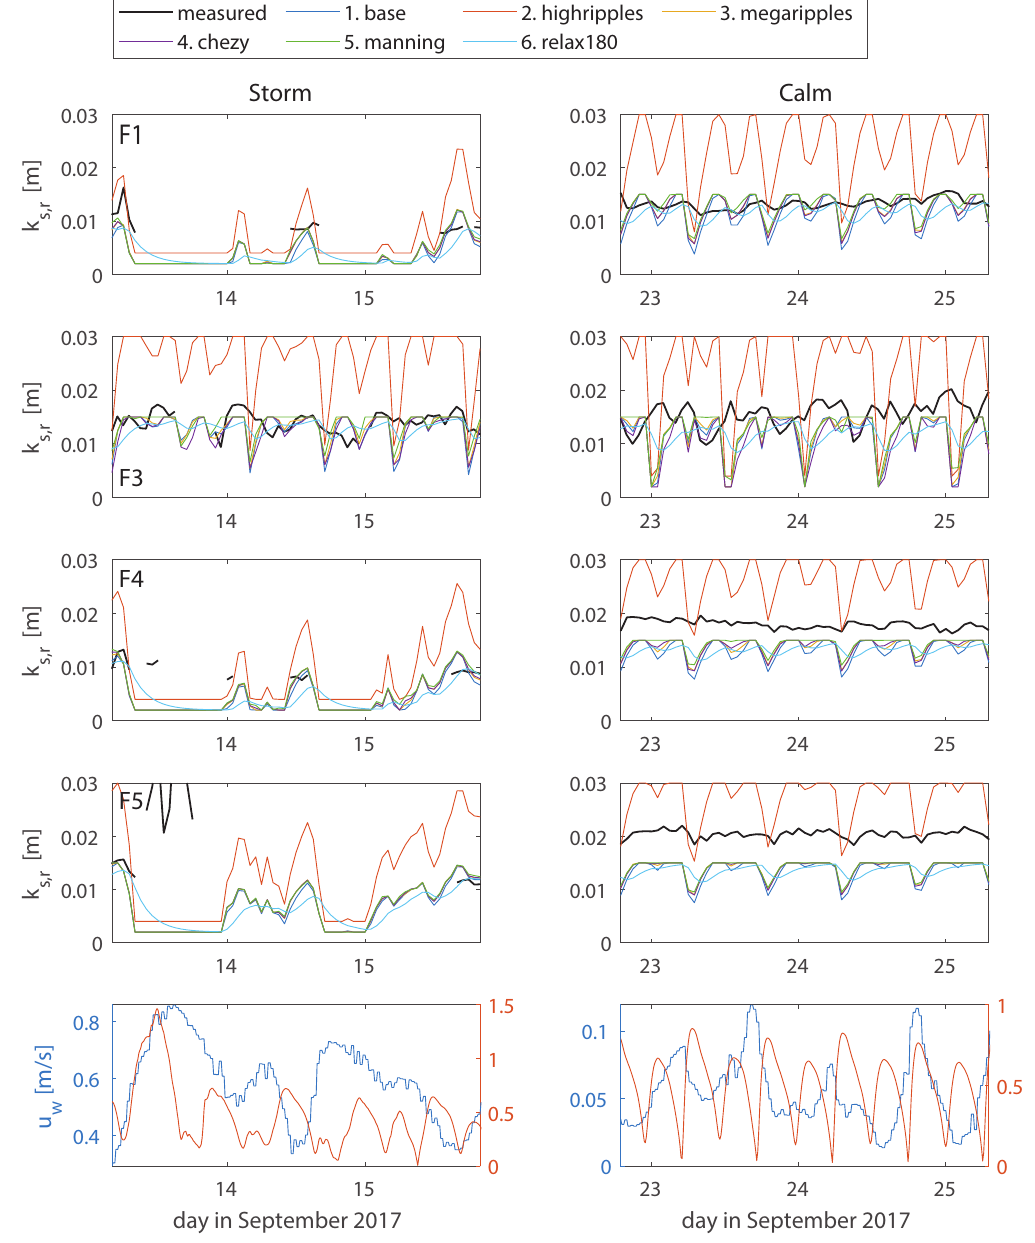
Figure 4. Top four rows: measured and modelled (scenarios 1–6) ripple roughness k s , r through time at all frame locations (F1, F3, F4 and F5) during the storm ( left ) and the calm ( right ) period as denoted in Figure 3. Bottom row: near-bed orbital velocity u w and depth-averaged current velocity u c at Frame 1 during the storm ( left ) and the calm ( right ) period. (As the ripple roughness was constant in scenarios 7–9, they are not plotted in this